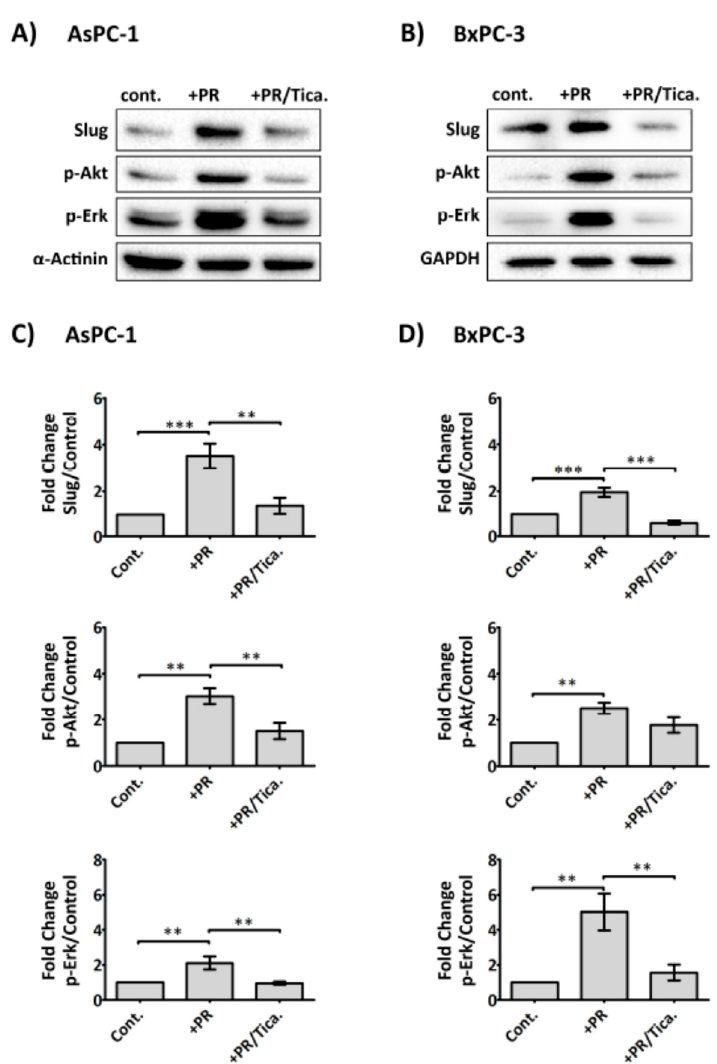
Figure 6. Anti-platelet drug ticagrelor, an antagonist of the purinergic receptor P2Y 12 receptor, reduces the effects of PR on cancer cells. Representative immunoblots show Slug, p-Akt and p-Erk expression in AsPC-1 and BxPC-3 cells after incubation with PR ± ticagrelor (Tica, 10 µM) for 2 h. Sample preparations and immunoblotting were performed as previously described. The final concentration of PR used was equivalent to releasate from 5 × 10 8 platelets/mL. Bar graphs ( C ) and ( D ) show the expression levels of the proteins of interest relative to the loading control. Columns represent fold change in protein expression level compared to control non-treated cells. n ≥ 5. *** p < 0.0001, ** p < 0.001, ** p < 0.05. Data are presented as mean ± SEM. One way ANOVA with post-hoc Bonferroni’s Multiple Comparison Test was used to examine the significance of the mean. cont.: control.